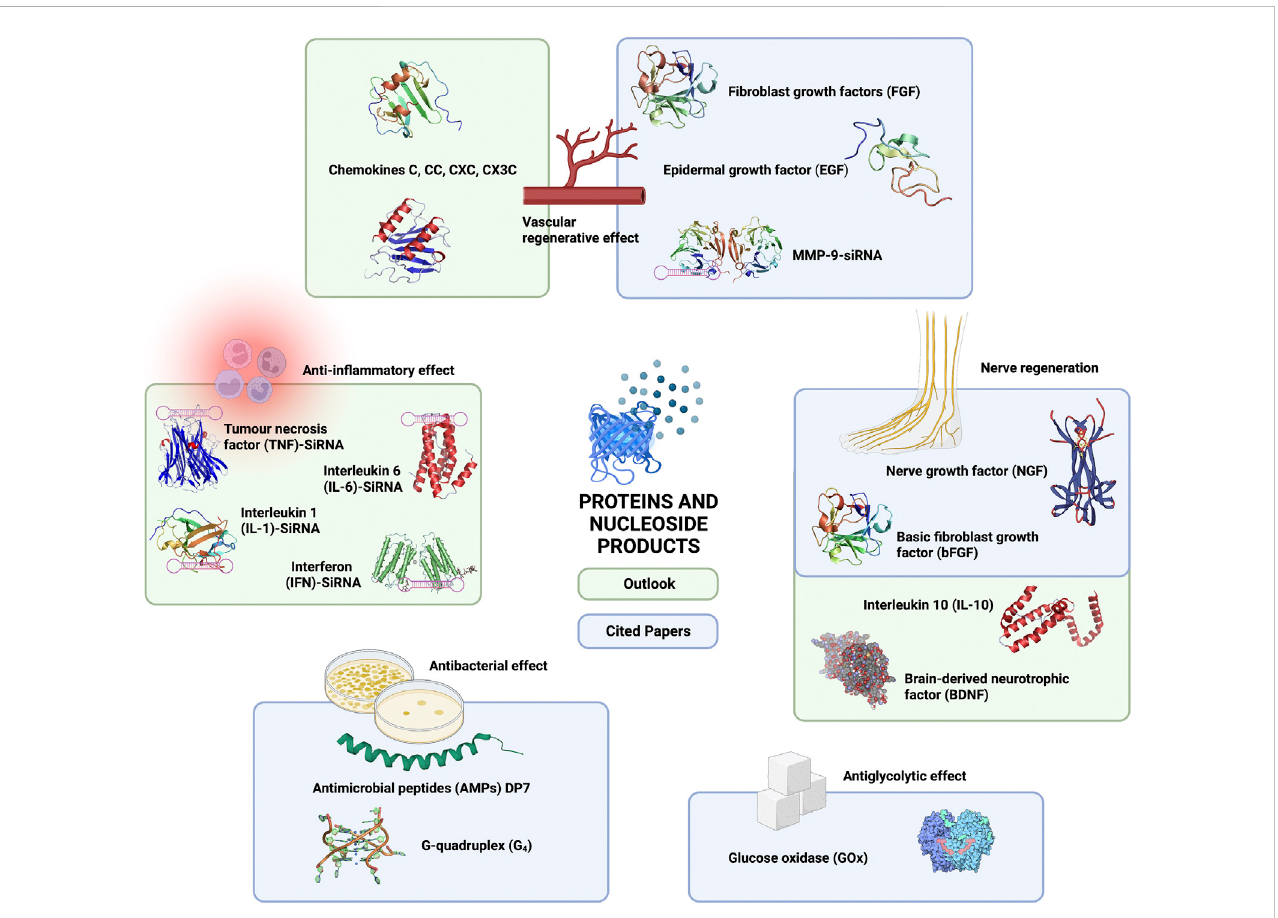
FIGURE 6 Current and future outlook of proteins (cytokines/peptides/enzymes) and nucleoside products in hydrogel composites in the treatment of chronic diabetic ulcers.